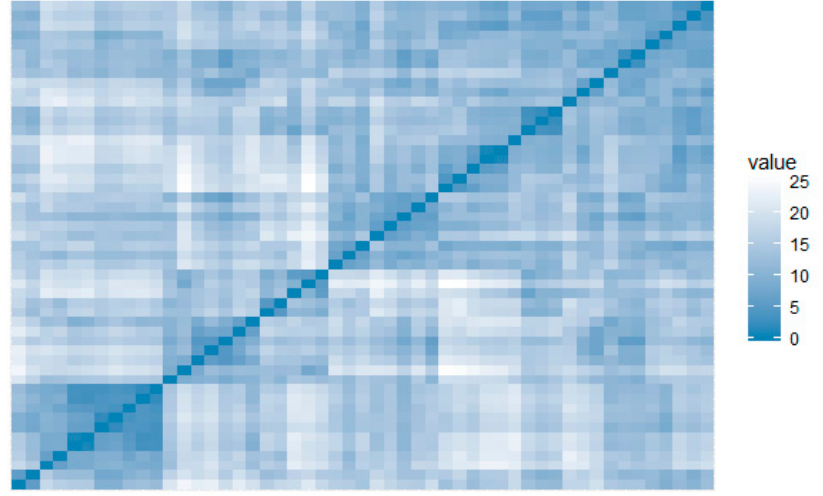
Figure 4. The quality of clustering based on visual assessment of the cluster tendency (VAT).